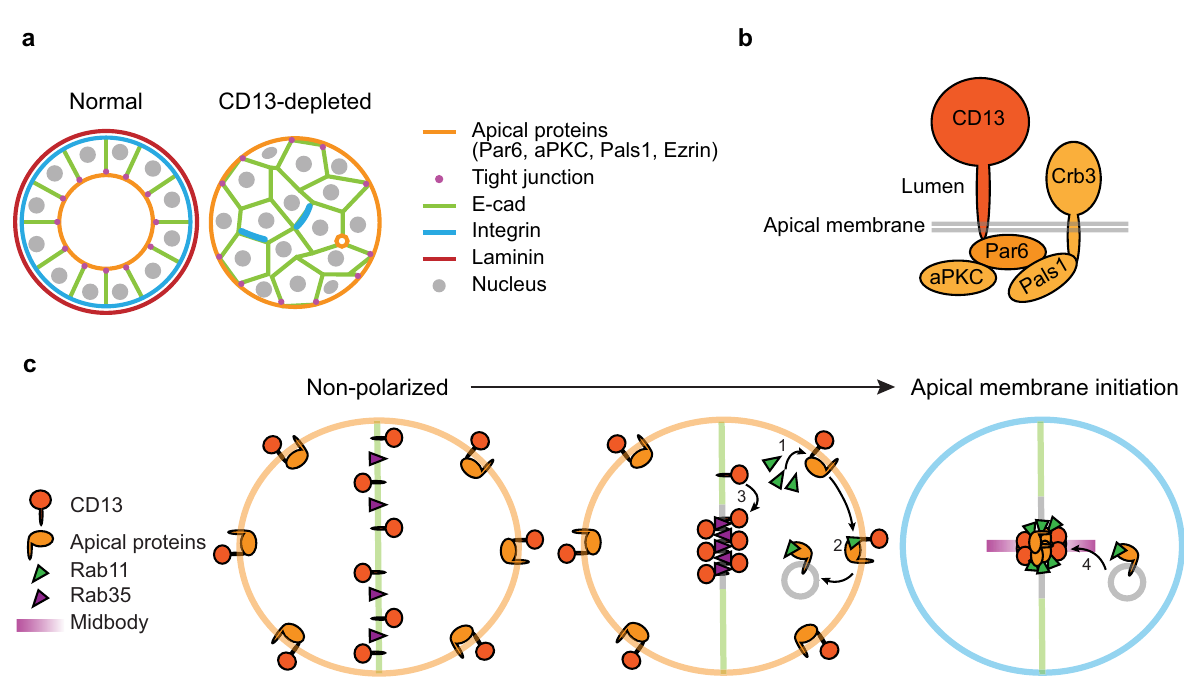
Fig. 8 Proposed model for CD13 functions in apical speci fi cation in Caco-2 cells. a Organization of control Caco-2 3D structures displaying apical-basal polarity and epithelial organization, and CD13-depleted cells showing inverted apical-basal polarity and impaired lumen formation. b CD13 associates with apical complex containing Par6, aPKC, Pals1, and Crb3. c Proposed events by which CD13 functions to establish the orientation of apical-basal polarity. CD13 associates with apical proteins (1) and is required for their loading to Rab11-mediated endosomes (2). In parallel, CD13 establishes Rab35 at the AMIS (3) necessary to capture vesicles containing apical determinants for apical membrane initiation (4). See discussion for a further